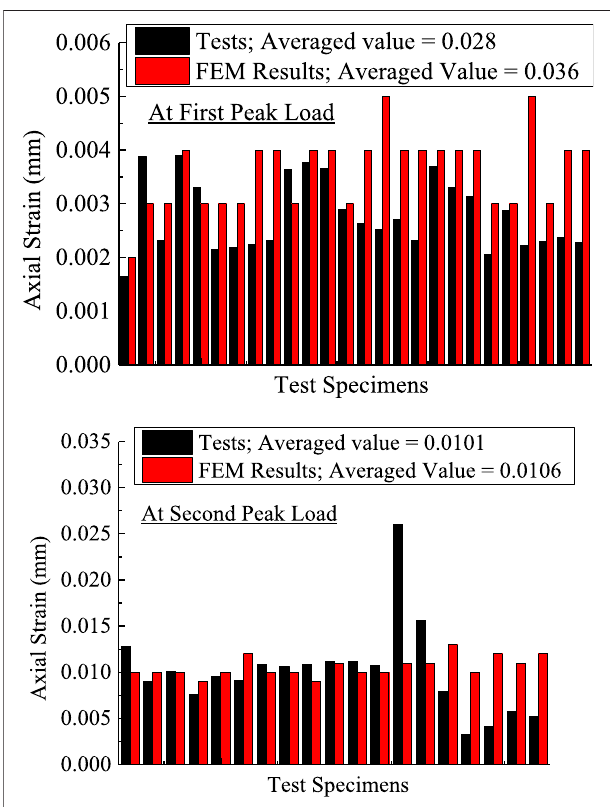
FIGURE 11 | Comparison of FE strain results of longitudinal bars at fi rst and second peak loads with the experimental data from AlAjarmeh et al. (2019a), AlAjarmeh et al. (2019b), AlAjarmeh et al.